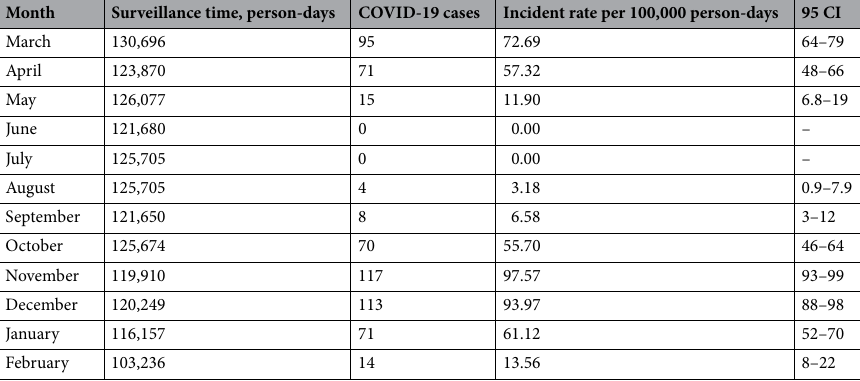
Table 2. Incidence of COVID-19 infection in hospital workers in Trieste from March 1, 2020 to February 28, 2021.